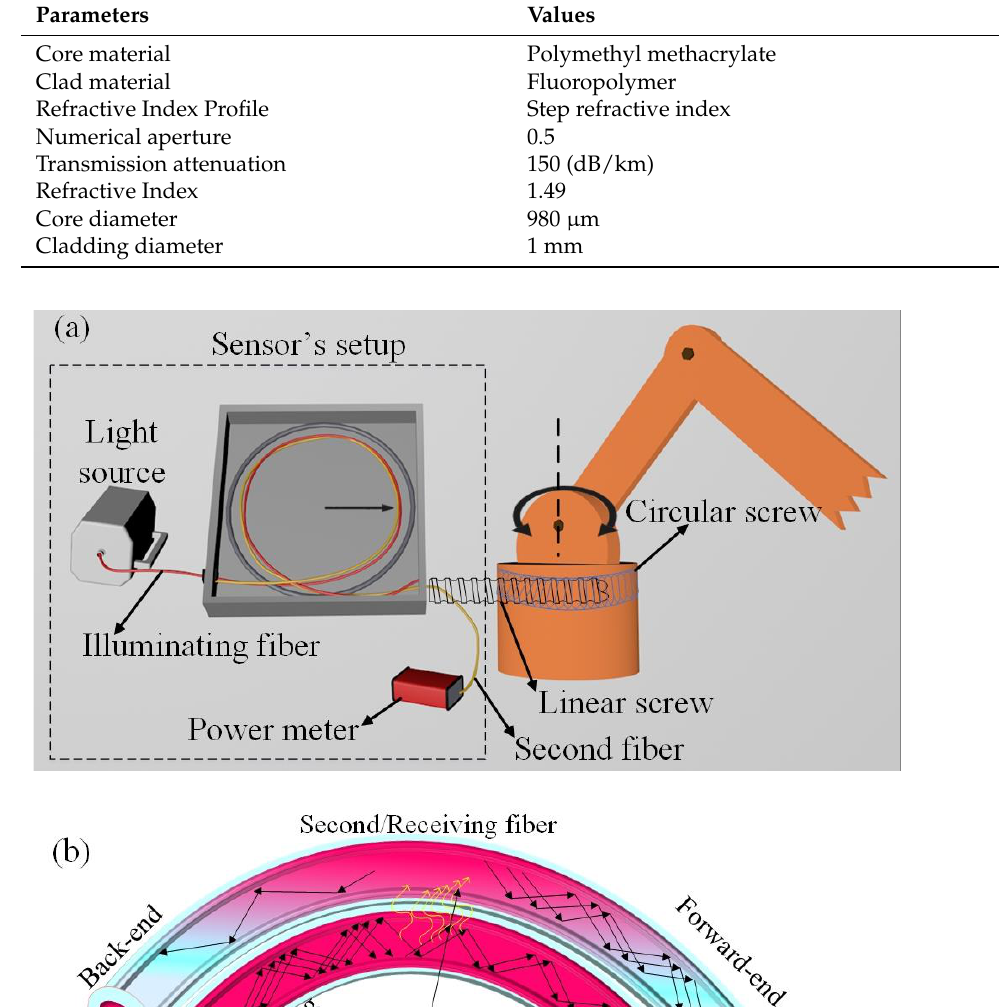
Table 1. The characteristic parameter of the Mitsubishi SK-40 PMMA fiber.